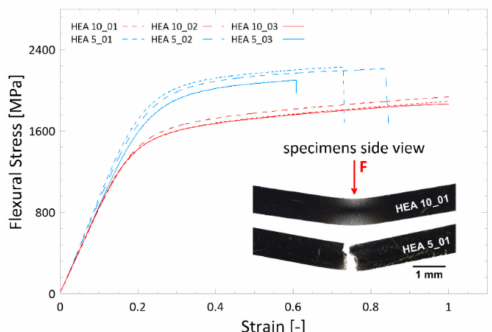
Figure 4. Stress–strain loading curves from three-point bending tests and detail photographs of the side view of specimens in the vicinity of the loading roller after test demonstrating the extent of plastic deformation without fracture for HEA 10 and fractured HEA